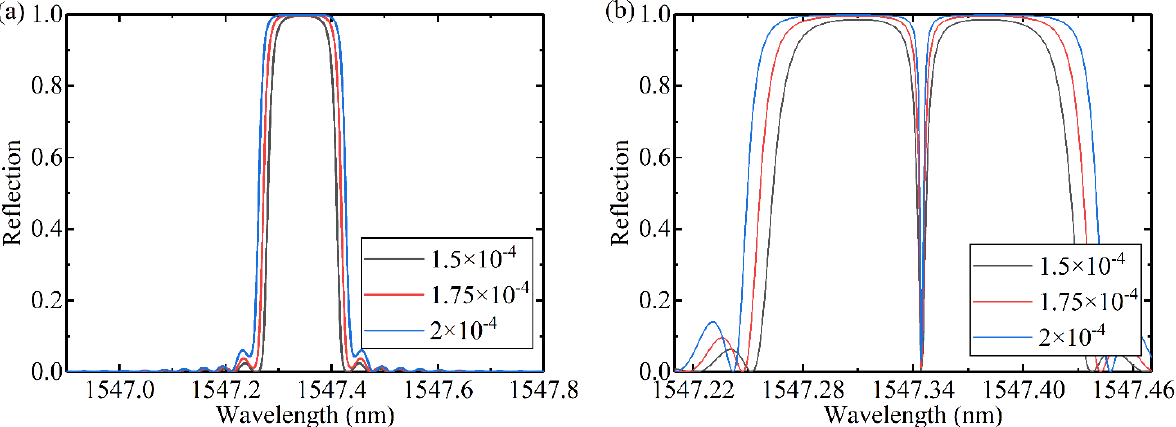
Figure 1. The reflection spectra of ( a ) FBGs and ( b ) π -PS-FBGs with different refractive index modulation.